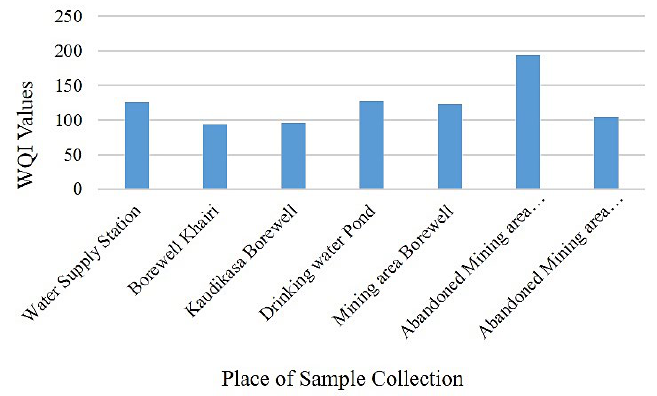
Fig. 1. Graphical representation of water quality index of collected water